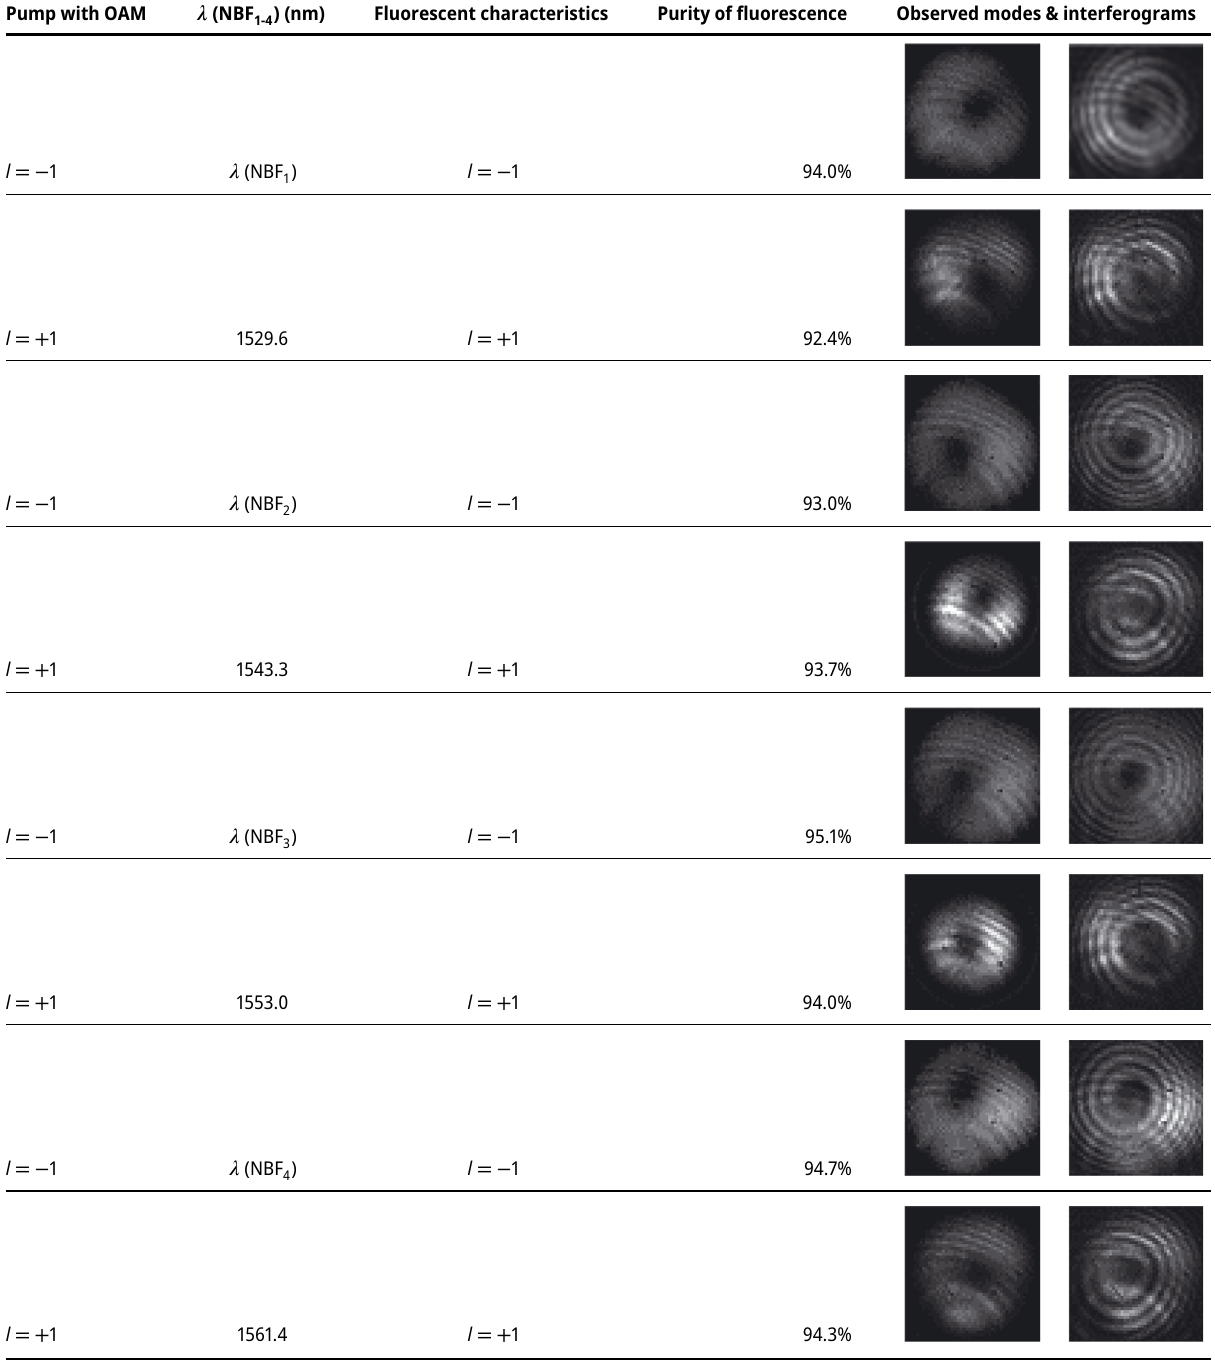
Table 1: Fluorescent characteristics at 1529.6, 1543.3, 1553.0, and 1561.4 nm generated by l = − 1 and + 1 pumps at 980 nm. Pump with